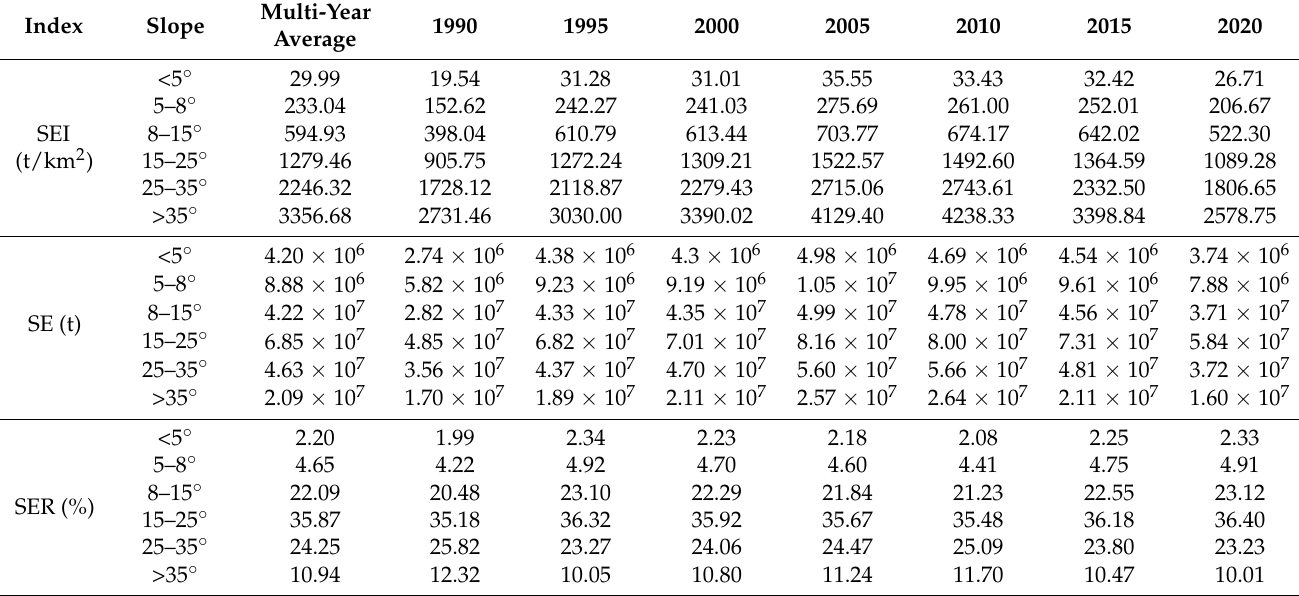
Table 8. SEI, SEA, and SER of different slopes in the